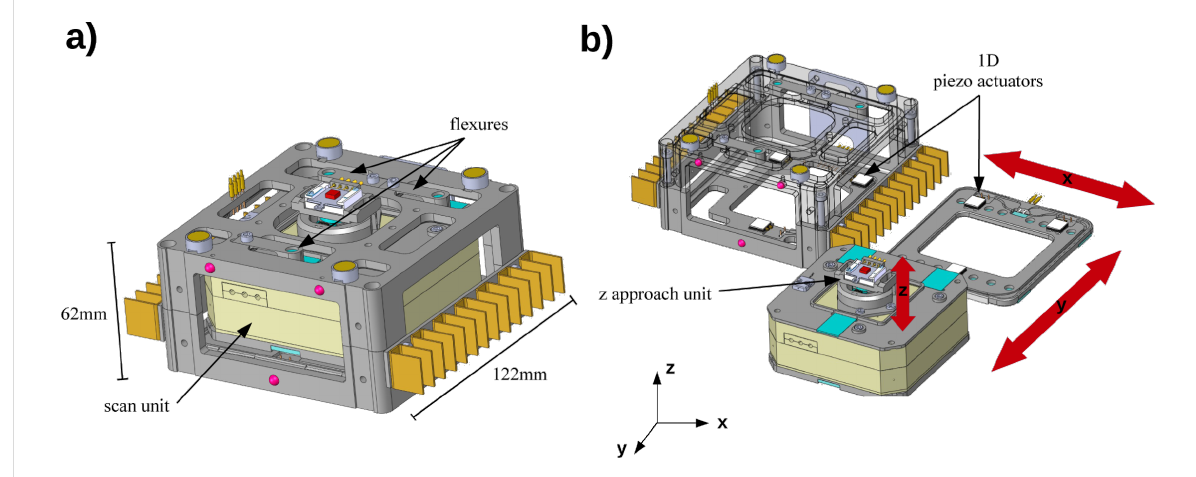
Figure 3: Coarse positioner and scan unit. Panel a shows the entire unit. In panel b the unit is stripped down into smaller parts. The coarse positioner consists of two stages in lateral directions, each driven by three shear piezo actuators. The stages are compressed by three flexures. The piezo step motor in the aperture of the scanner allows to approach the sample to the probe with nanoscale accuracy.